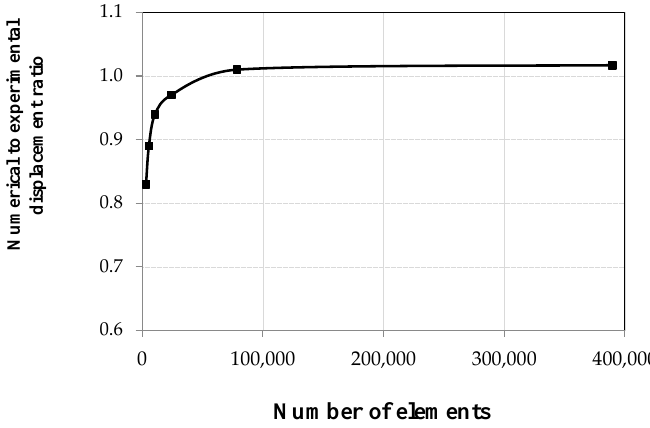
Figure 4. Mesh sensitivity analysis.